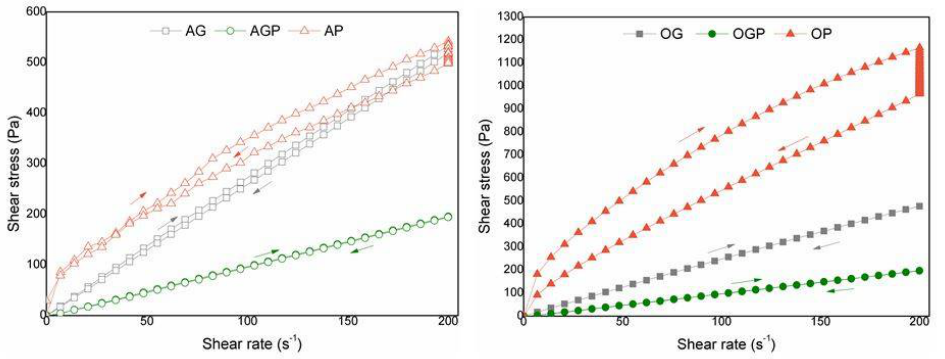
Figure 3. Bio-polyols flow curves.